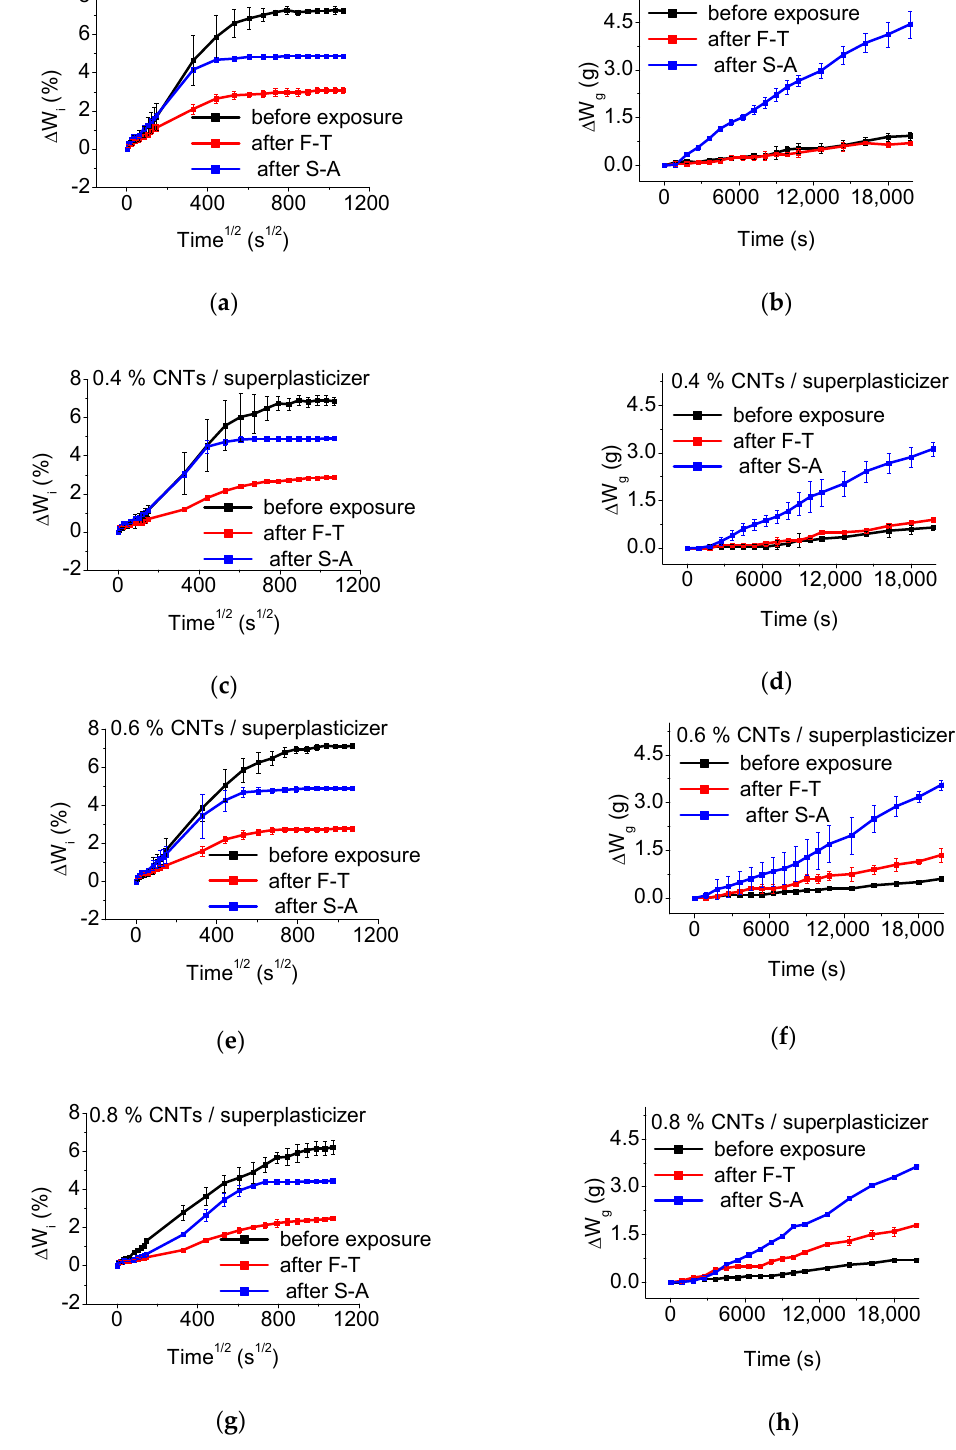
Figure10. E ff ectofexposurestateonthewaterabsorption( a , c , e , g )andgaspermeability( b , d , f , h )profiles Figure 10. Effect of exposure state on the water absorption ( a , c , e , g ) and gas permeability ( b , d , f , h ) of mortars with: ( a , b ) 0.2, ( c , d ) 0.4, ( e , f ) 0.6, and ( g , h ) 0.8 wt.% CNT contents, prepared using profiles of mortars with: ( a ), ( b ) 0.2, ( c ), ( d ) 0.4, ( e ), ( f ) 0.6, and ( g ), ( h ) 0.8 wt.% CNT contents, prepared superplasticizer as using superplasticizer as dispersant.